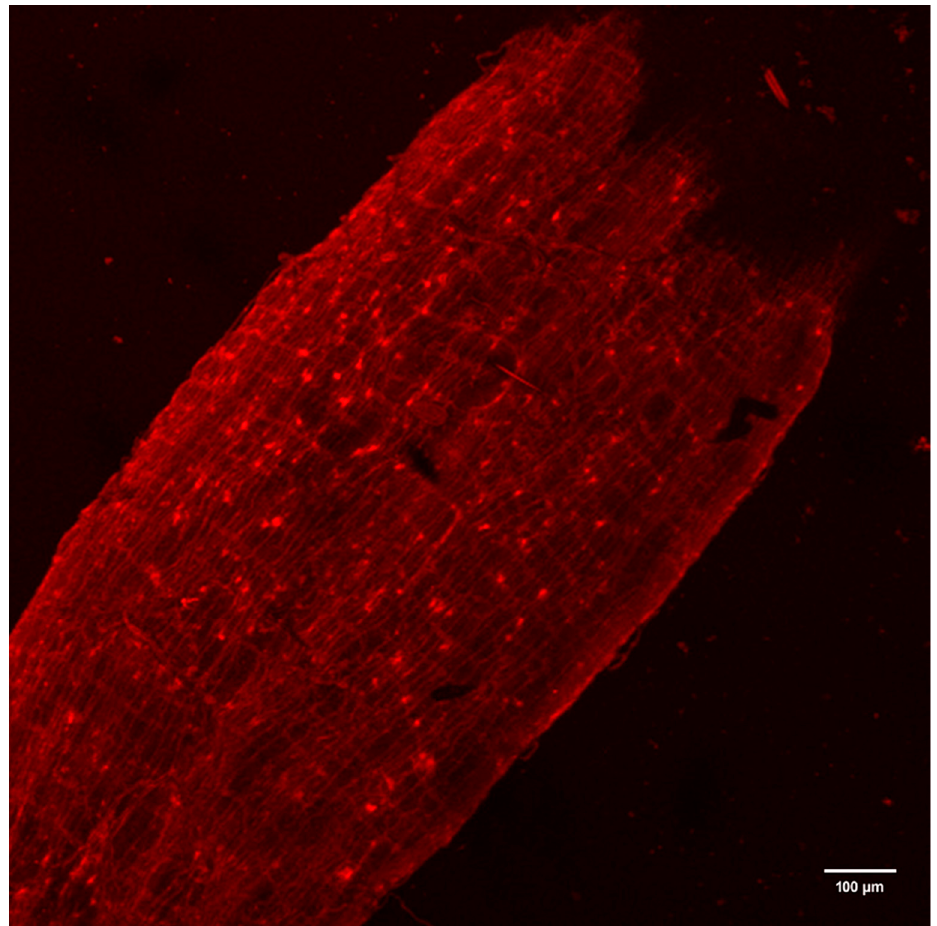
Figure 3. Fluorescent laser confocal micrograph showing the distribution of ECs in the MG from a non-viremic blood-fed mosquito at day 5 post-bloodmeal. Immunoreactive ECs labeled for FMRFamide granules are observed along the entire length of the PMG demonstrated by cell-associated TX-Red fluorescence. 200 ×